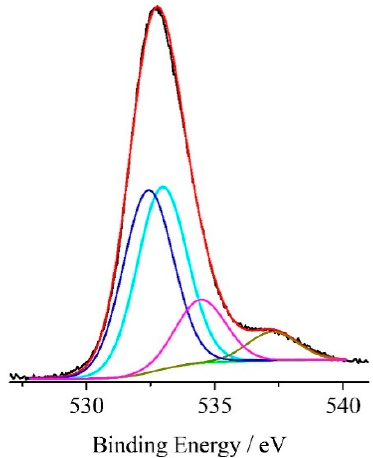
Figure 3. Al-K α excited XPS of the CNPs-Naphthyl-Di-AE sample in the O 1s energy region. The black line refers to the experimental profile; the green line refers to the background; the Gaussian at 532.3 (blue line), 532.9 (cyan line), 534.4 (magenta line) and 537.3 eV (dark yellow line) represent the four O 1s components; the red line, superimposed to the experimental profile, refers to the sum of the Gaussian components.